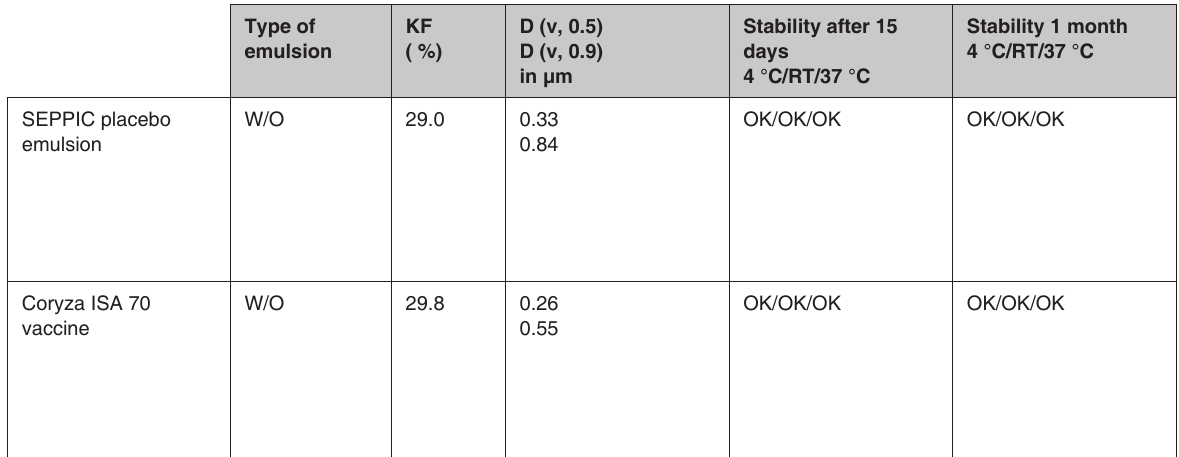
TABLE 1B Comparative evaluation of the coryza special vaccine formulated with ISA 70 adjuvant and a SEPPIC placebo emulsified in the same adjuvant. Karl Fisher method (KF) defines the emulsion water content while D (v) is the mean of particles di-